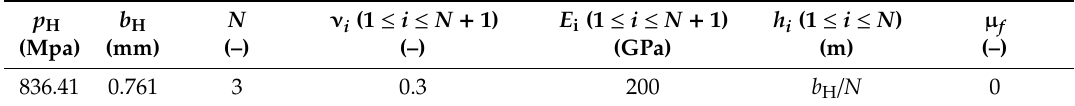
Table 1. Input parameters of the present method for simulating a half plane of the substrate material subjected to subjected to surface contact loading.